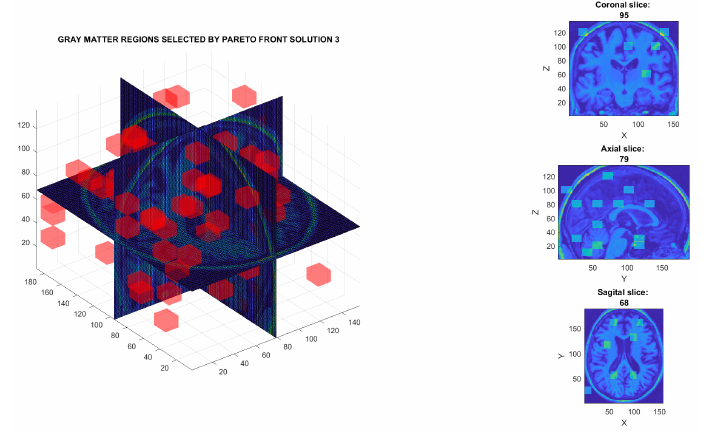
Figure 14. Selected brain regions from the third Pareto solution (whole matter source,